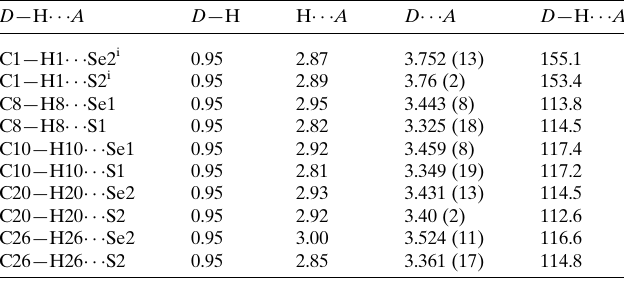
Table 6 Experimental details. Crystal data Chemical